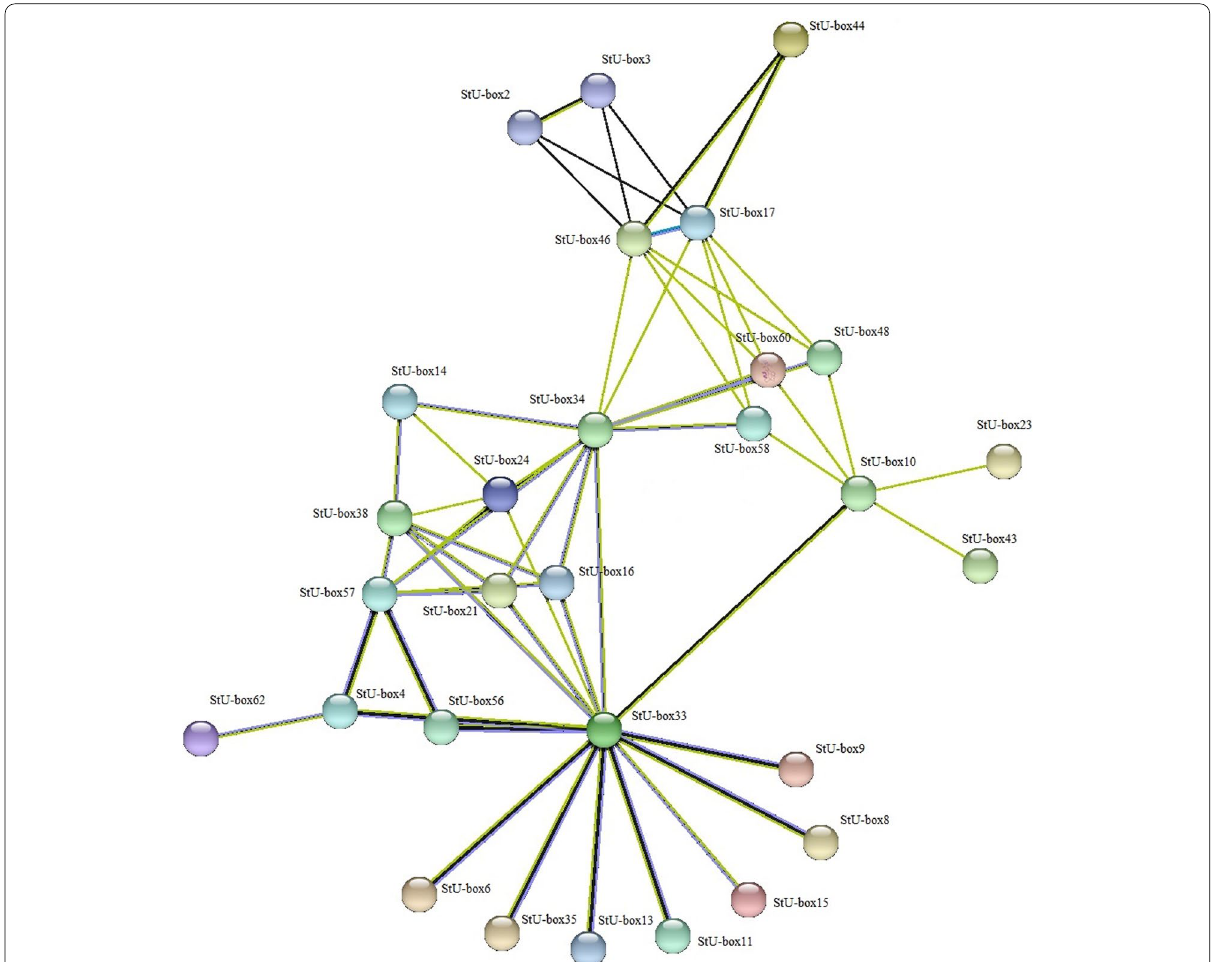
Fig. 9 Interactions of co-expressed network genes of U-boxs in potato. The web based tool “String” (http:// string- db. org/) was utilized to predict the